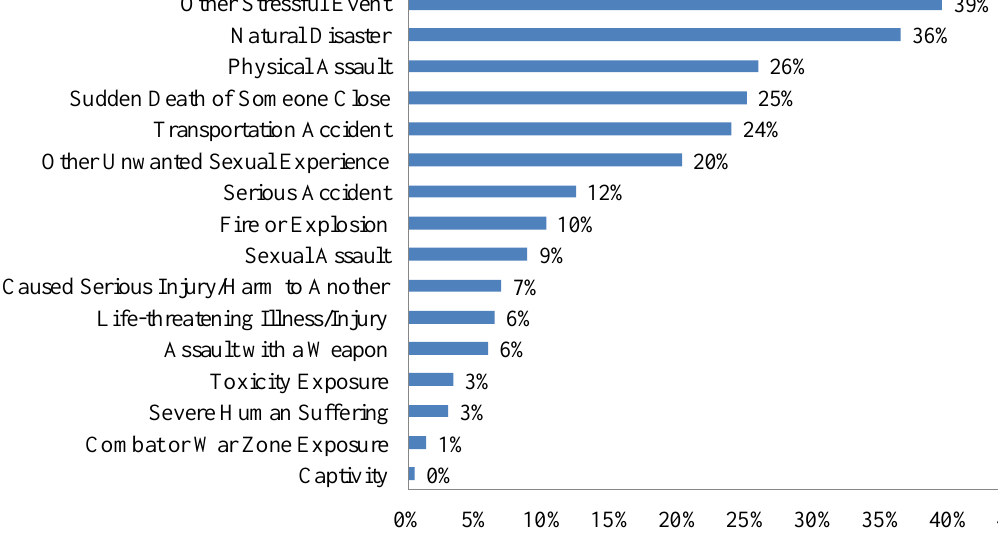
Figure 1. Endorsement of Traumatic Life Events.